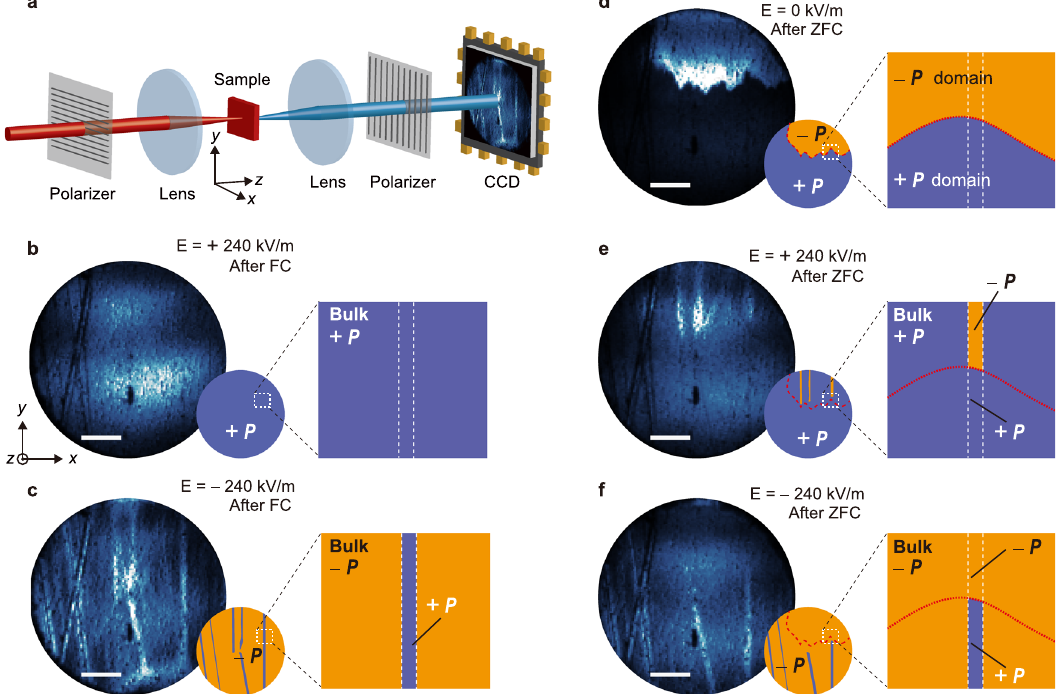
Fig. 3 Multiferroic nature of the ribbons in the bulk multiferroic AF2 phase. a Schematic of the experimental setup for SHG imaging measurements. The incident light with the photon energy _ ω = 1.05 eV was polarized along the x axis. The SHG light with the polarization of E 2 ω jj y (tensor component χ yxx ) was used for the imaging. The electric fi eld was applied along the y axis, which is parallel to the ferroelectric polarization direction. b , c SHG images at 10 K (the bulk AF2 phase) obtained after fi eld cooling at þ 240 kV/m in fi elds of b þ 240 kV/m and c (cid:4) 240 kV/m. d – f Electric fi eld dependence of the SHG images at 10 K after zero- fi eld cooling obtained in fi elds of d 0 kV/m, d þ 240 kV/m, and e (cid:4) 240 kV/m. Scale bars are 200 μ